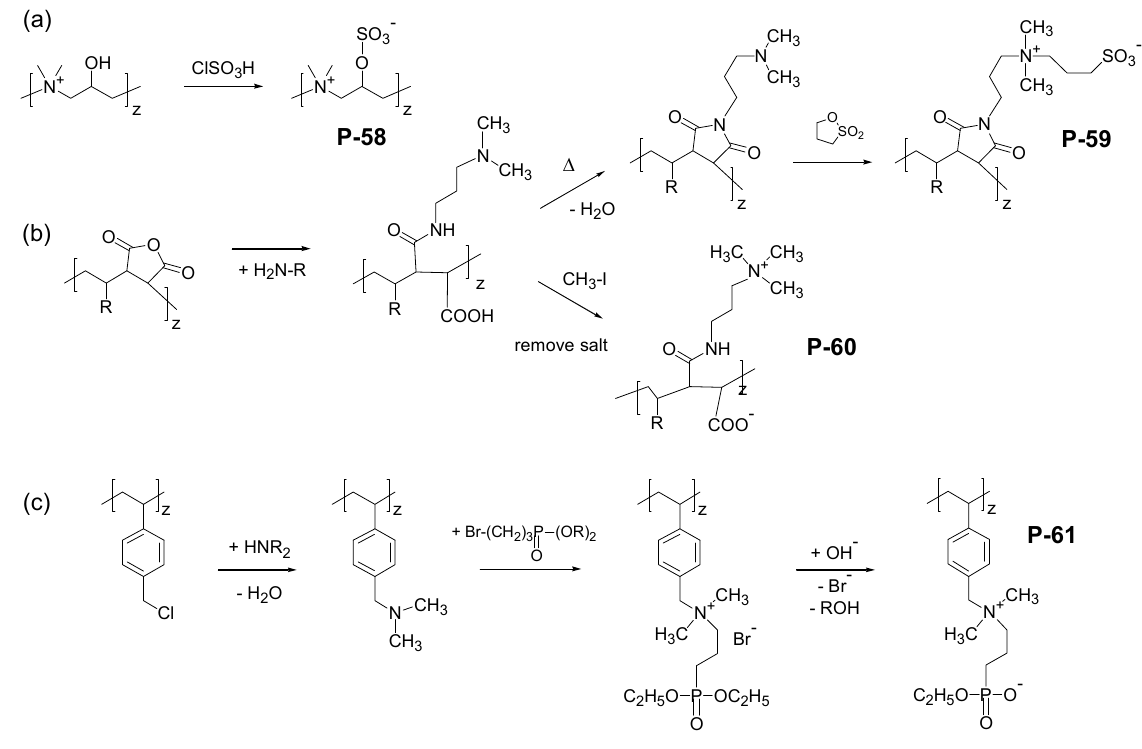
Figure 13. Polyzwitterions made by unusual post-polymerization modifications: